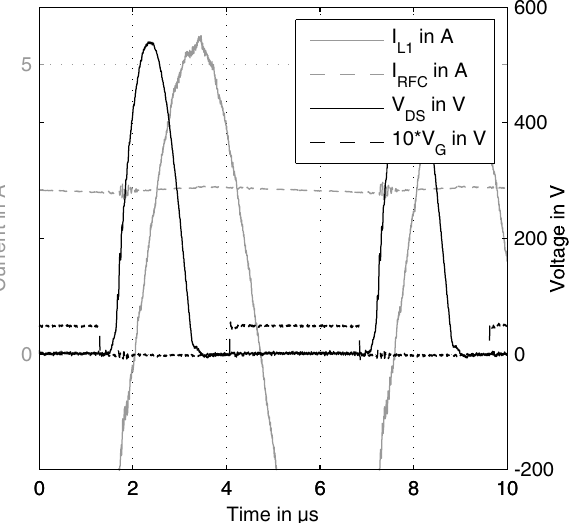
Figure 12. Measurement results for amplifier #2. Active power approx.